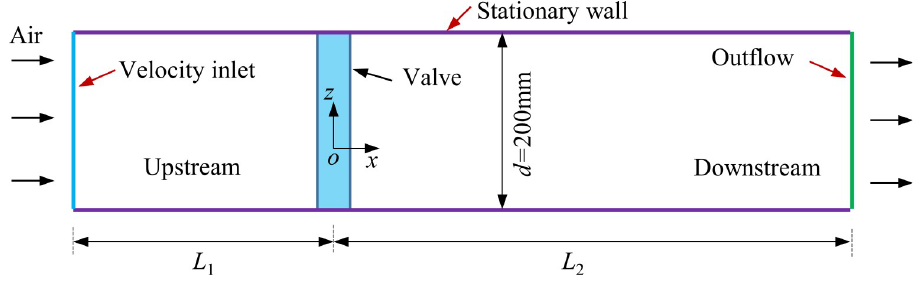
Fig 3. Schematic of the computational domain for two types of regulating